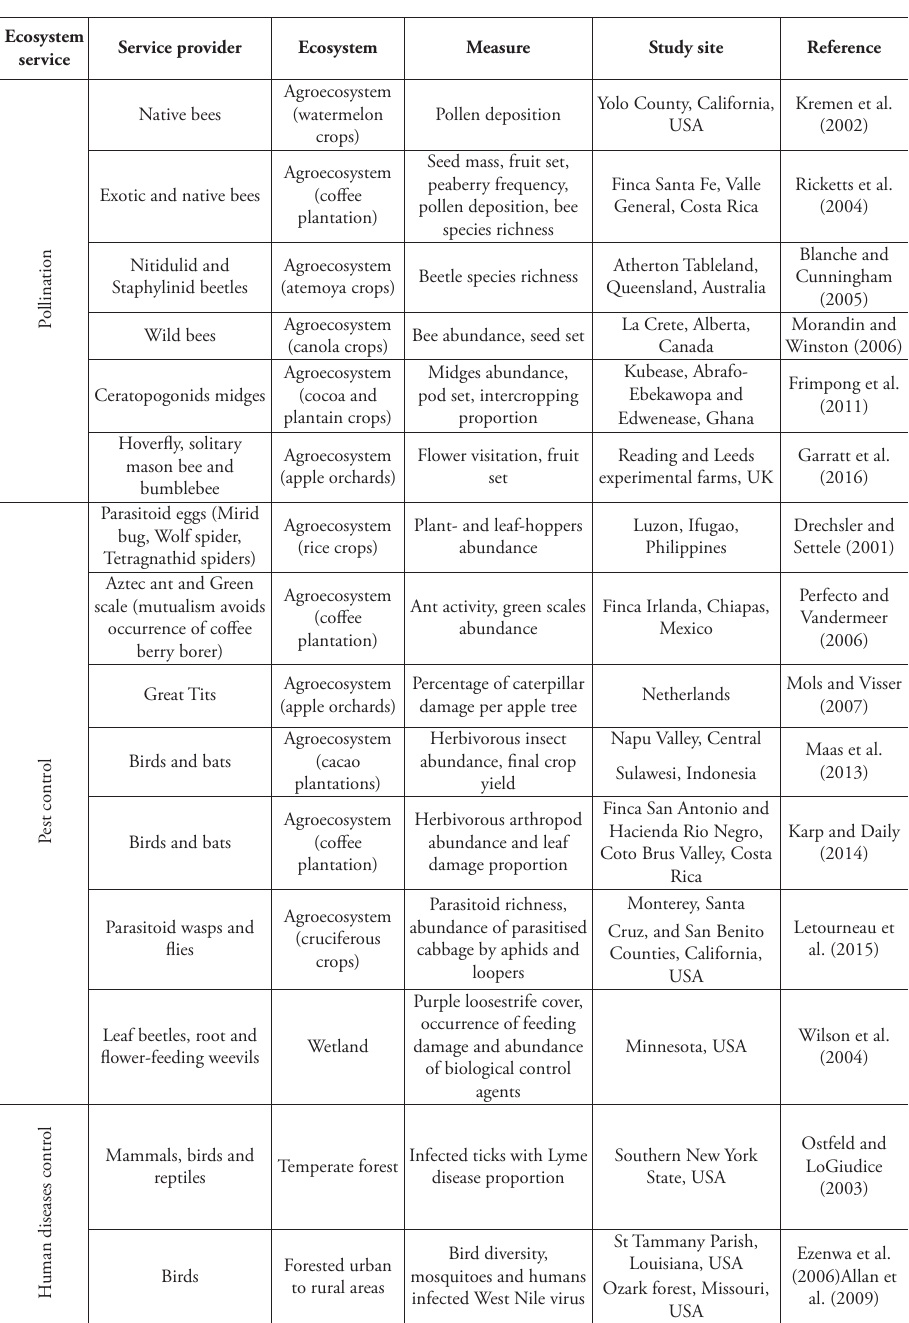
Table 1. Faunal ecosystem services. Selected examples of studies where regulation ecosystem services provided by fauna are assessed, describing the providers, ecosystem benefited by the service and service quantification